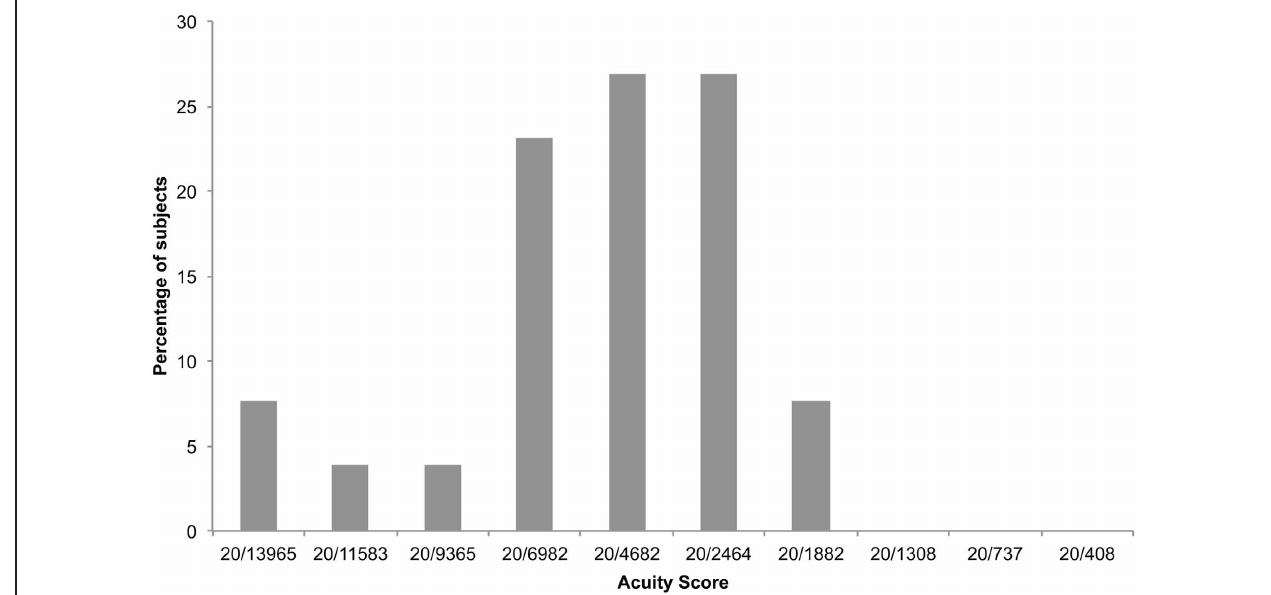
FIGURE 2 | Percentage of participants who achieved each vOICe acuity score (9/12 correct responses) in experiment 1.